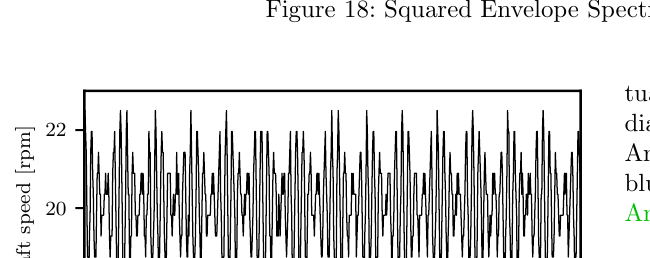
Figure 18: Squared Envelope Spectrum after bandpass filtering.